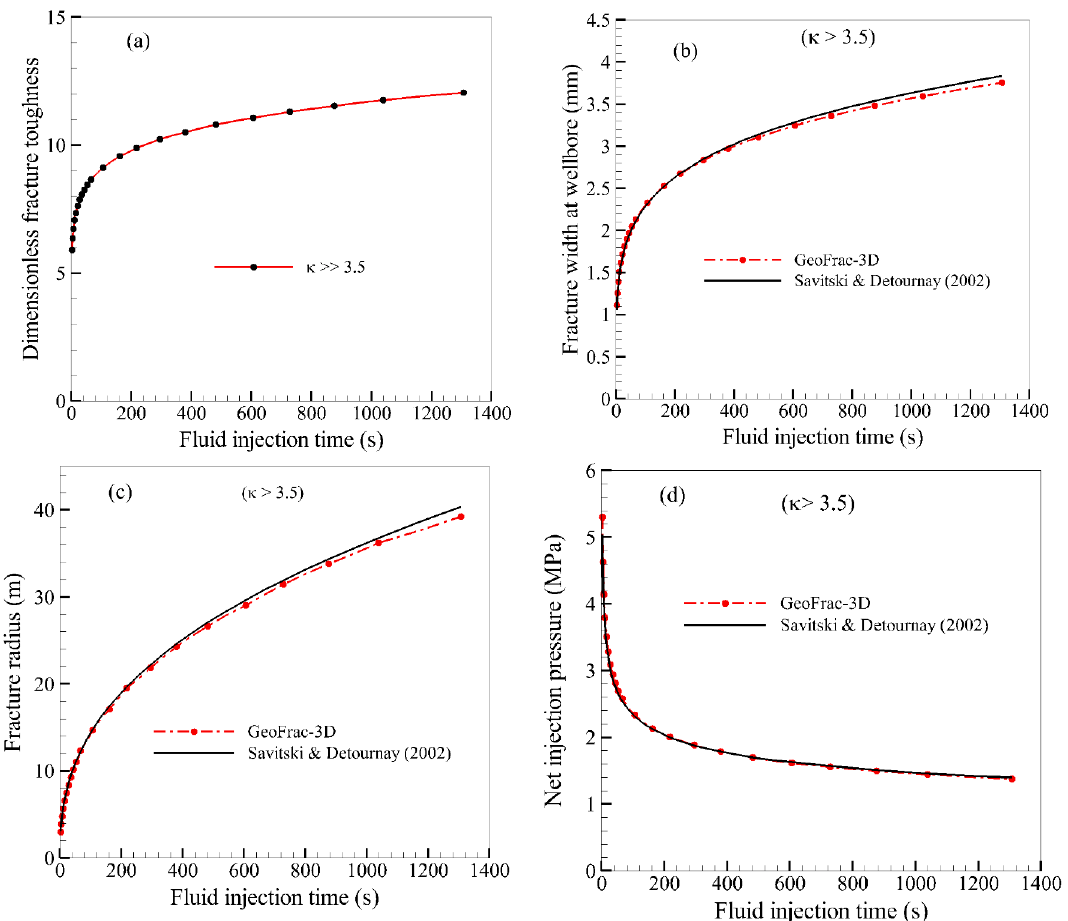
Figure 4. Comparisons of GeoFrac-3D results against the analytical solution by Savitski and Detournay [54]. Temporal variation of ( a ) dimensionless fracture toughness, ( b ) fracture aperture at the wellbore, ( c ) fracture radius, ( d ) the net injection pressure (fluid injection rate = 0.01 m 3 / s, fluid viscosity = 0.001 Pa.s, fracture toughness = 10 MPa.m 0.5 ). The dimensionless fracture toughness values (>3.5) in part (a) demonstrate that the fracture is propagating in the toughness dominated regime.